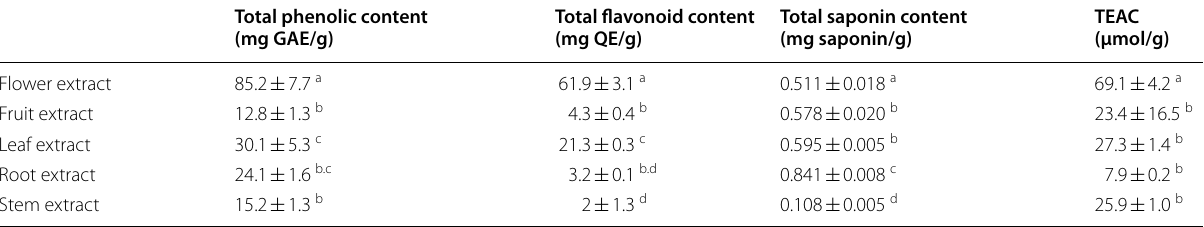
Values not sharing a common superscript letter in the same column were significantly different (Tukey’s HSD test, p < 0.05) Values of the same parameter (vertical columns) with different superscripts differs significantly ( P < 0.05)